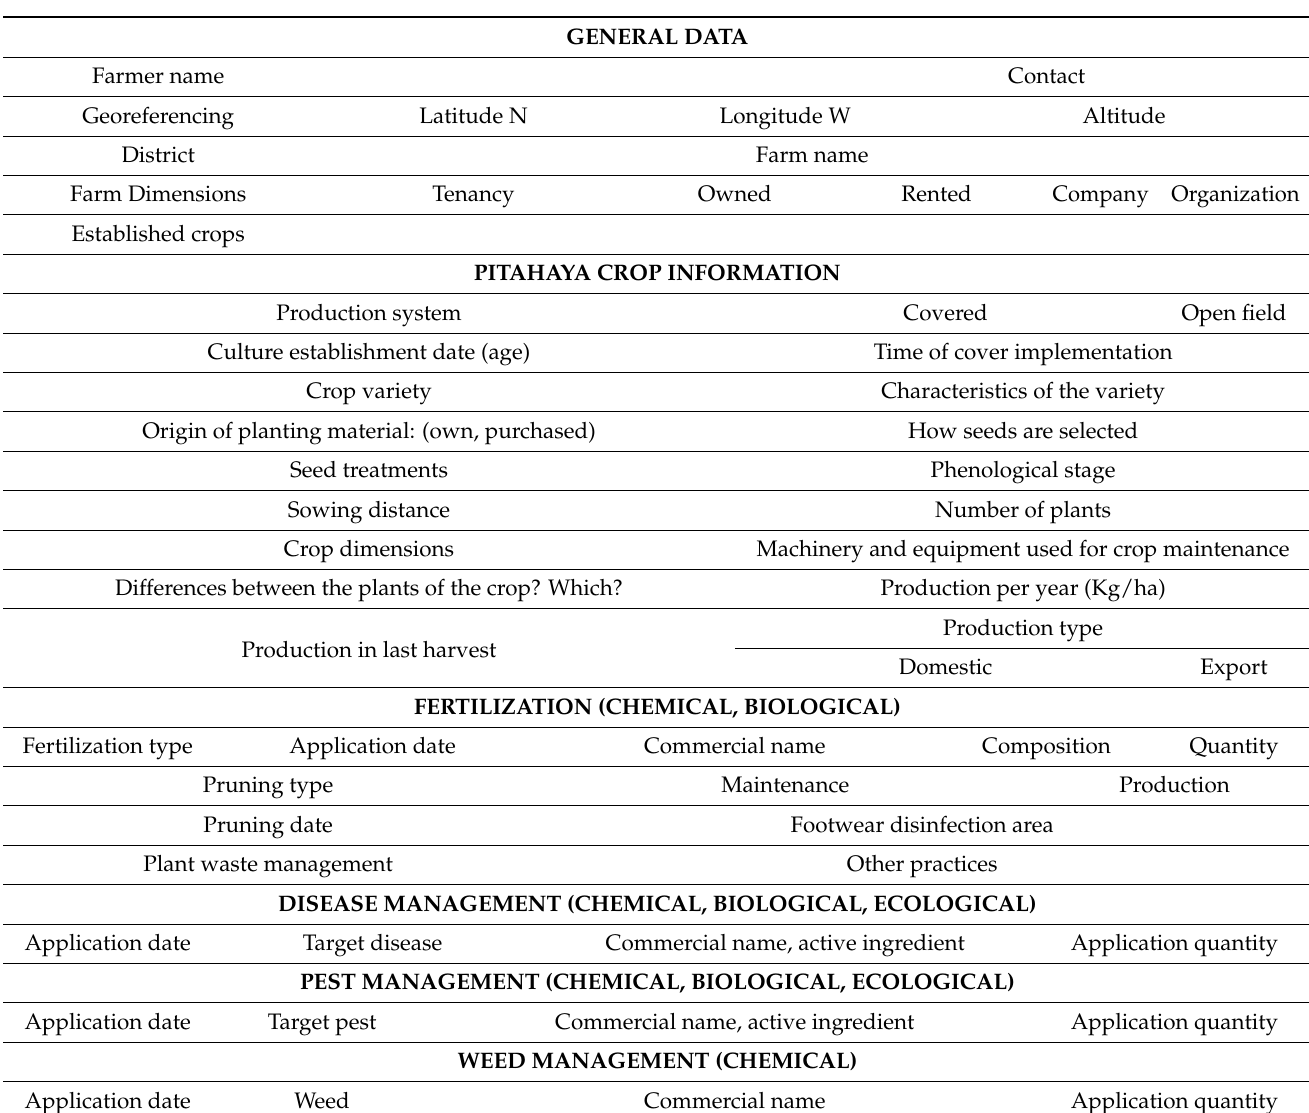
Table 1. Model survey for the execution of the diagnostic census of the 13 farms involved in the study. GENERAL